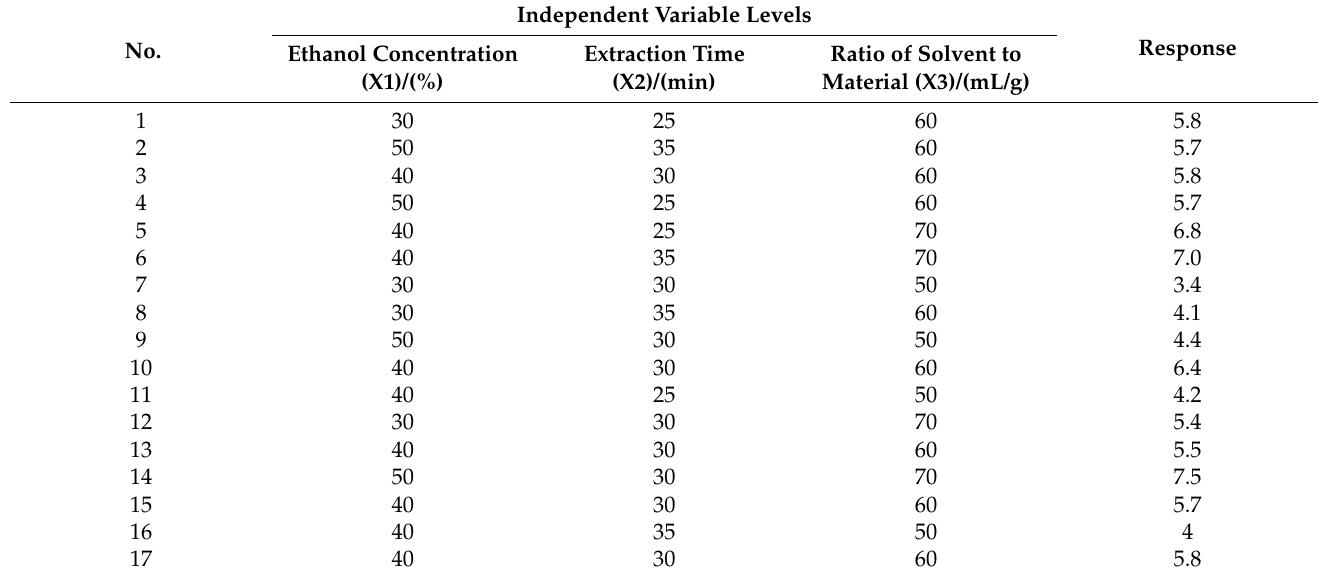
Table 2. Box–Behnken experimental design and the results for the extraction yield of TFW ( n =